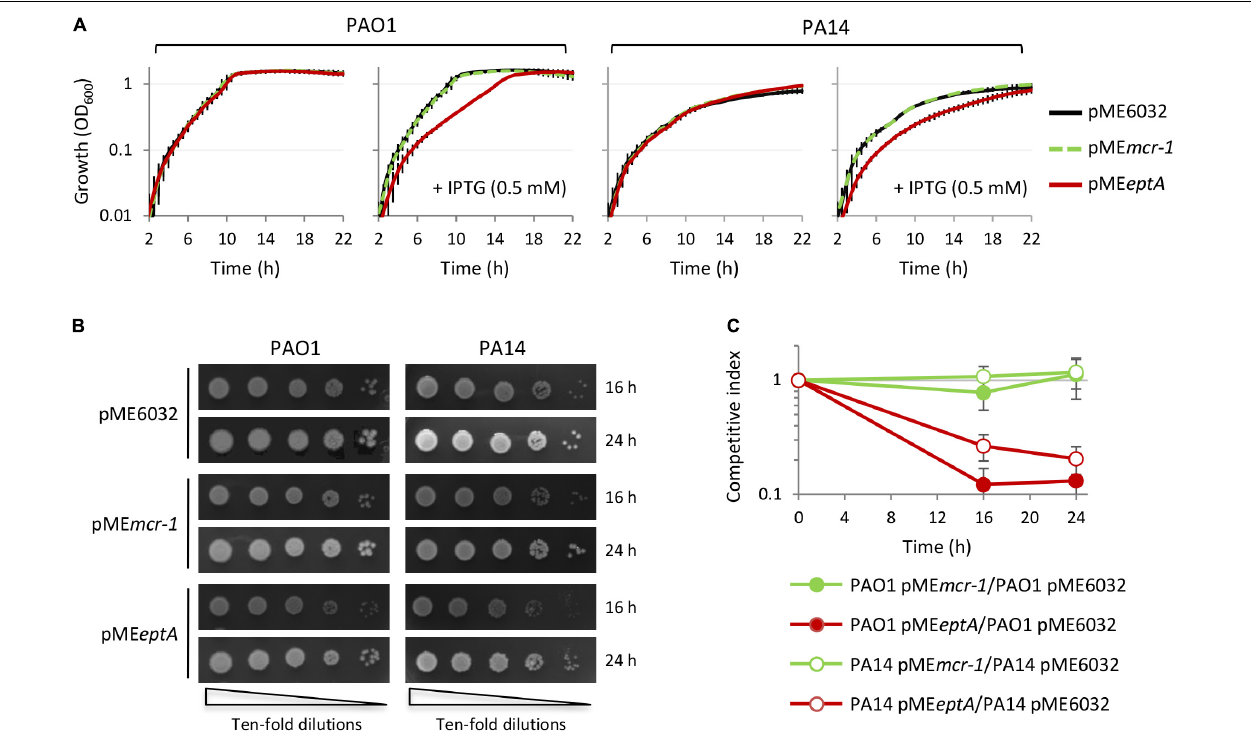
FIGURE 3 | Effect of MCR-1 or EptA overexpression on P. aeruginosa growth. (A) Growth curves of PAO1 or PA14 containing the empty vector pME6032 (black lines), pME mcr-1 (green lines), or pME eptA (red lines), cultured in the absence or in the presence of 0.5 mM IPTG. (B) Colony growth of the same strains described in (A) on agar plates containing 0.5 mM IPTG. (C) In vitro competition between PAO1 or PA14 cells with the empty vector and cells overexpressing MCR-1 or EptA in the presence of 0.5 mM IPTG. Data represent the mean ( ± SD) or are representative of at least three independent experiments.